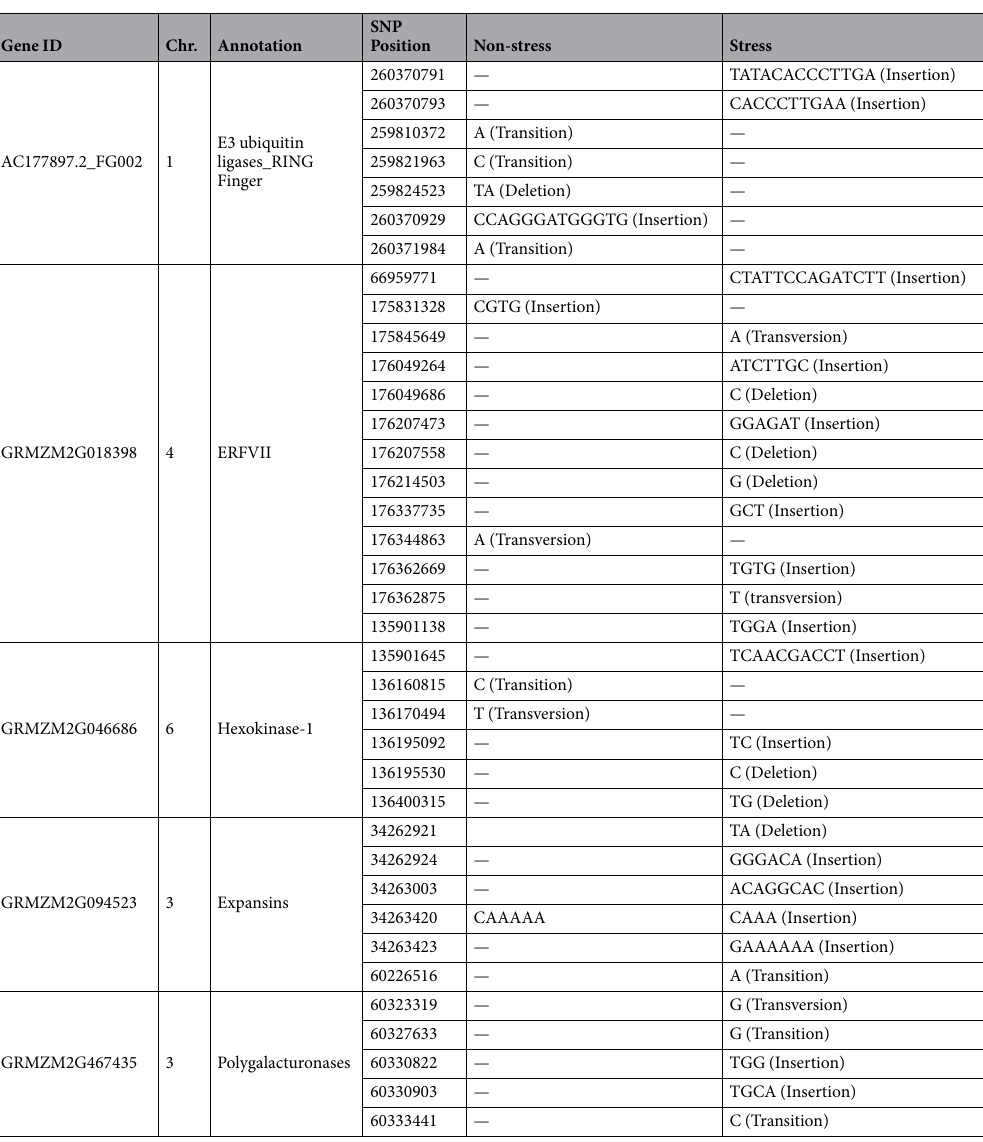
Table 2. Polymorphisms identified in the genes expressed in non-stress and stress samples by comparing with